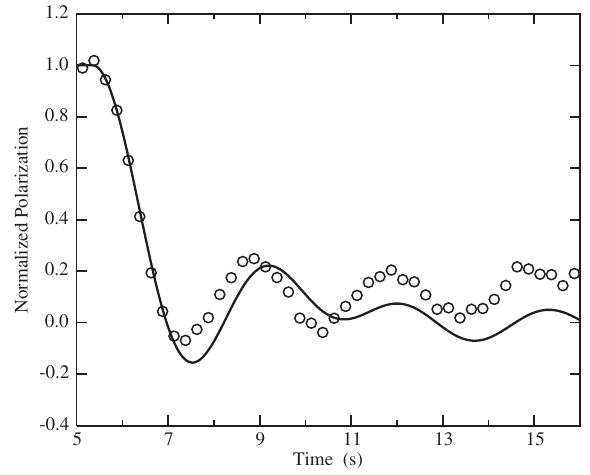
FIG. 17. The same as Fig. 16 but with a solenoid strength of 8 : 87 (cid:2) 10 (cid:1) 7 rev = turn . The solenoid was turned off at t ¼ 15 s